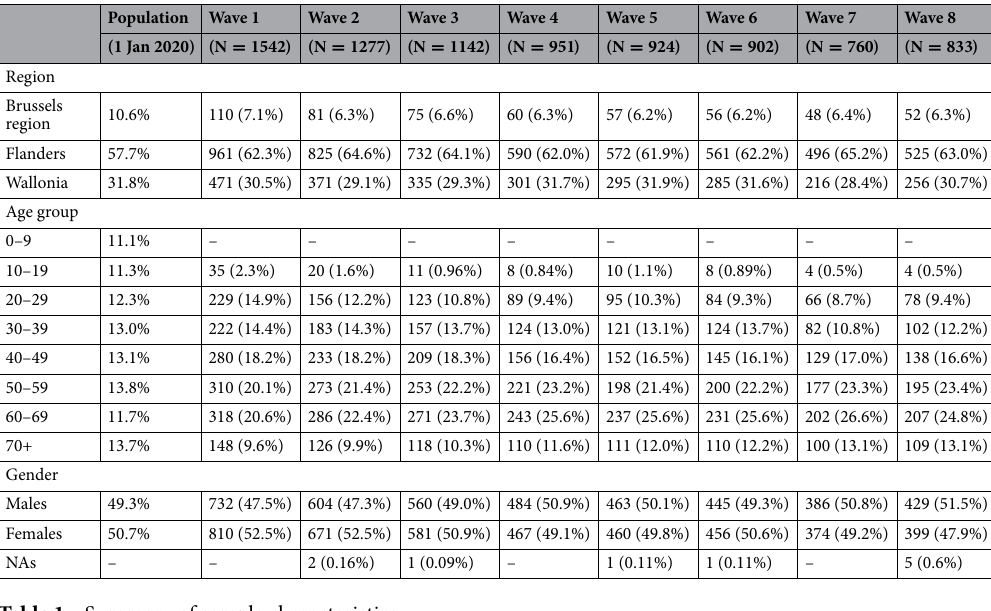
Table 1. Summary of sample